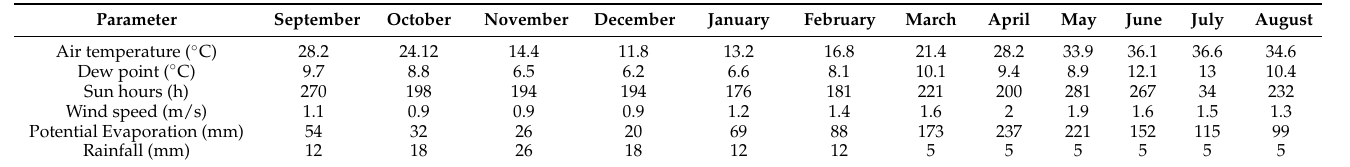
Table 2. Monthly average meteorological parameters at Behbahan synoptic station (2010–2011).